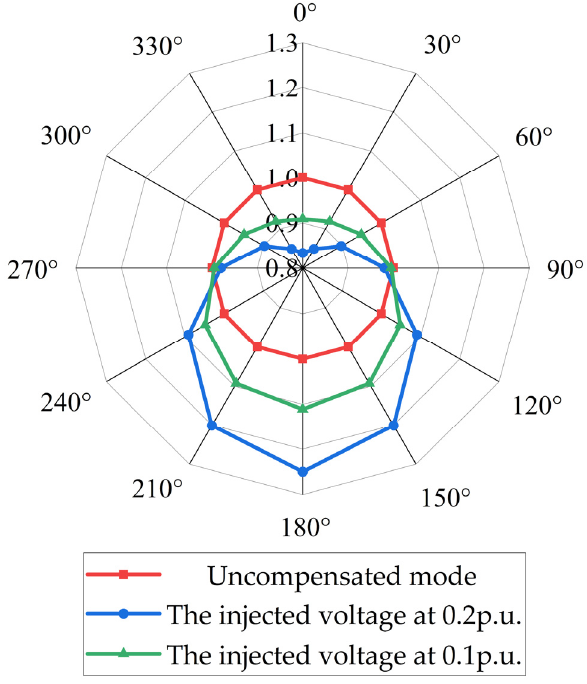
Figure 8. The variation of 1/ | k | under different phase angles of compensating voltage. It can be observed from Figure 8 that 1/ | k | gradually increased in the range of 0 ◦ to 180 ◦ , which may have caused the same trend of the fault current. Moreover, when the compensation angle was greater than 90 ◦ , 1/ | k | for ξ = 0.1 p.u. was greater than that